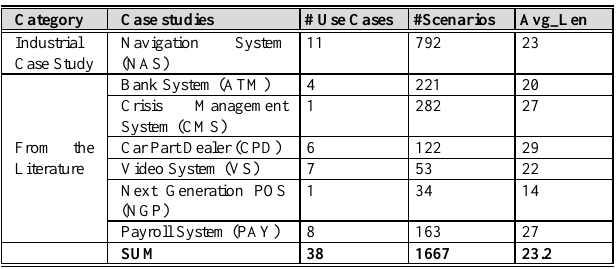
Table 1. Characteristics of the case studies